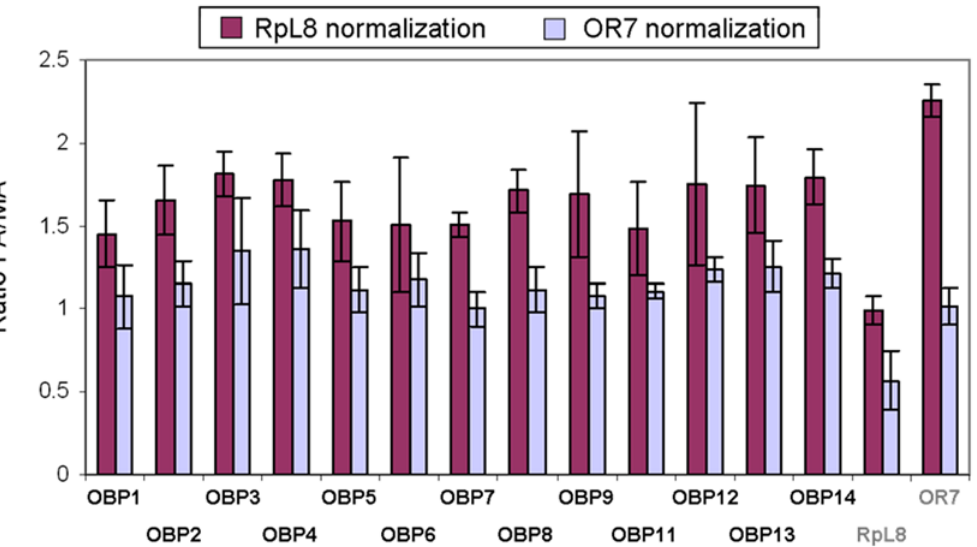
Figure 5. Expression of OBP genes in female and male antennae. Expression ratios (FA/MA) of thirteen olfactory-specific OBP genes and two control genes (RpL8, OR7) were calculated after quantification of bands intensities in semi-quantitative RT-PCR experiments. Antennal CDNAs of both sexes were normalized to the expression levels of CquiRpL8 (purple) and CquiOR7 (blue). Bars represent standard deviations.